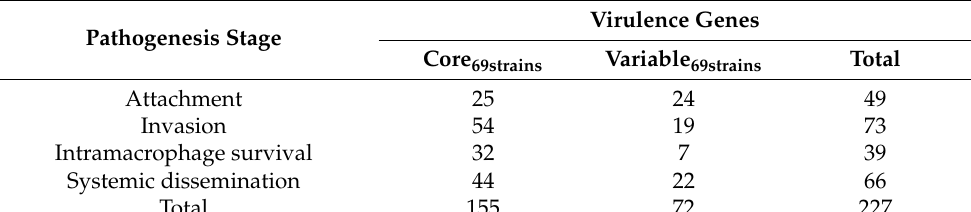
Table 6. Relative distribution of core and variable virulence genes and their participation in the different stages of pathogenesis in Salmonella enterica ( n = 69 strains).